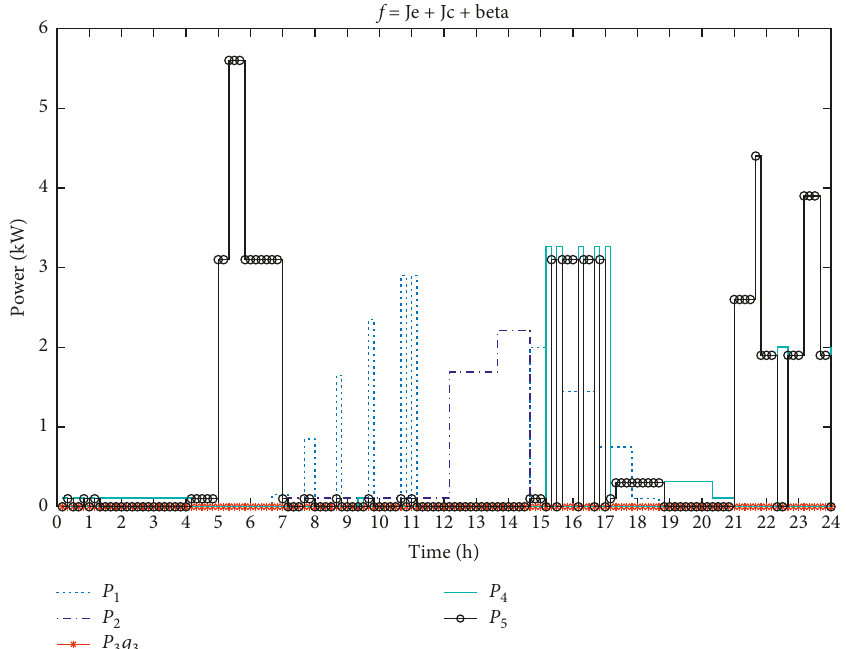
Figure 8: Power dispatch of the previous design in case